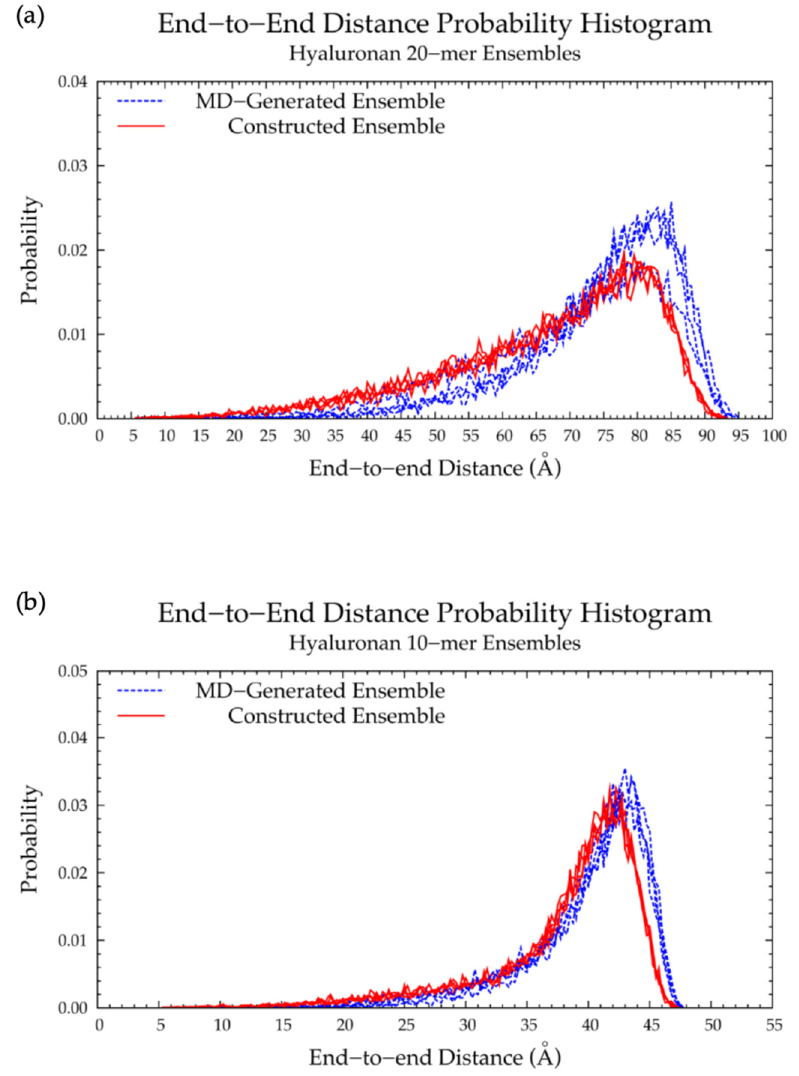
Figure 6. End-to-end distance probability distributions of MD-generated (blue dashed lines) and constructed (red solid lines) hyaluronan ensembles: ( a ) 20-mer and ( b ) 10-mer; probabilities were calculated for end-to-end distances sorted into 0.5 Å bins for the 20-mer and 0.25 Å bins for the 10-mer; each ensemble includes four sets of 10,000 conformations.